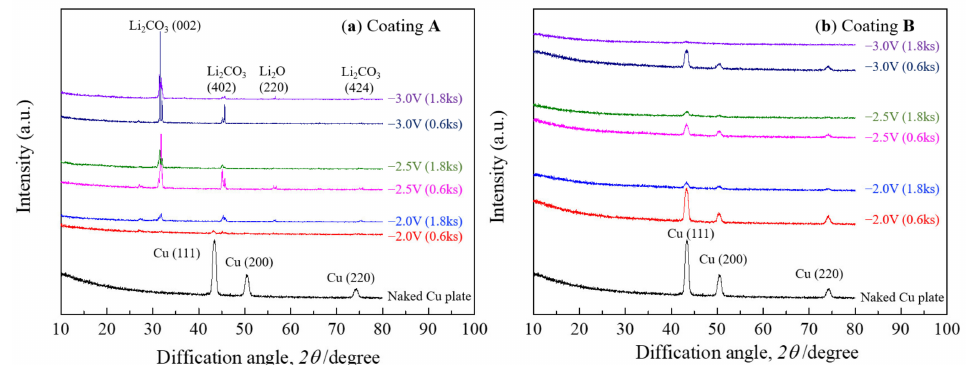
Figure 5. Grazing-incidence X-ray diffraction patterns of coatings A ( a ) and B ( b ) deposited at − 2.0 V, − 2.5 V, and − 3.0 V (vs. SSE) for 0.6 ks and 1.8 ks, with an incidence angle of 1.0 ◦ .